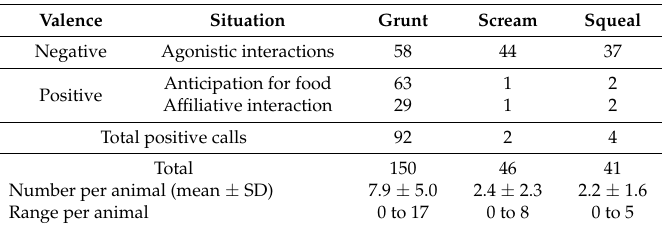
Table 3. Number of grunts, screams, and squeals analyzed according to the valence and the situation for each individual (including range; n = 19